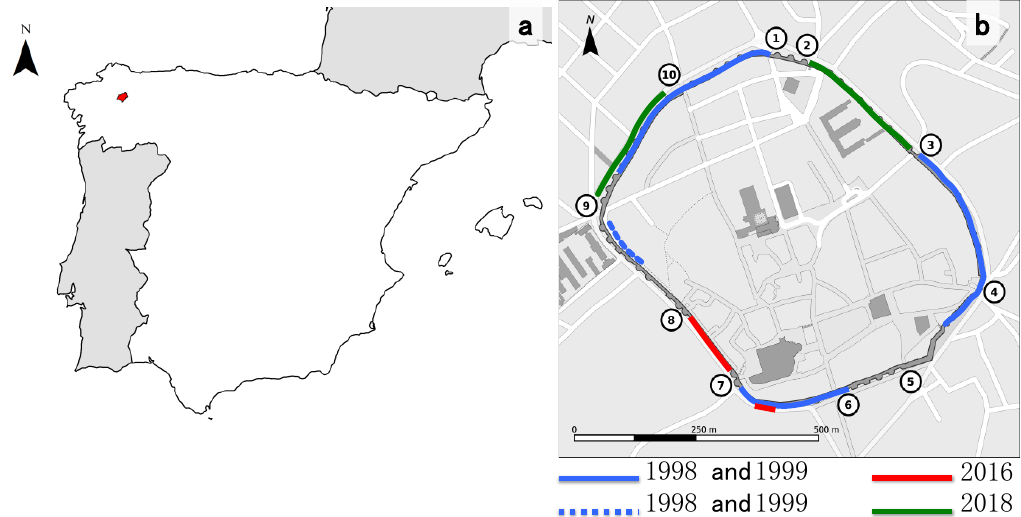
Figure 2. ( a ) ArcGIS Map of the Iberian Peninsula showing the location of the city of Lugo (red area); ( b ) map of the Roman wall of Lugo, showing the test areas of the wall (solid and dashed lines represent, respectively, internal and external faces of the wall) where the treatments were applied over time, and the entrance gates (1: San Fernando Gate, 2: False Gate, 3: Station Gate, 4: San Pedro Gate, 5: Bishop Izquierdo Gate, 6: Bishop Aguirre Gate, 7: Santiago Gate or Pexigo Gate, 8: Gate of El Carmen or Miñá Gate, 9: Bishop Odoario Gate, 10: New Gate).